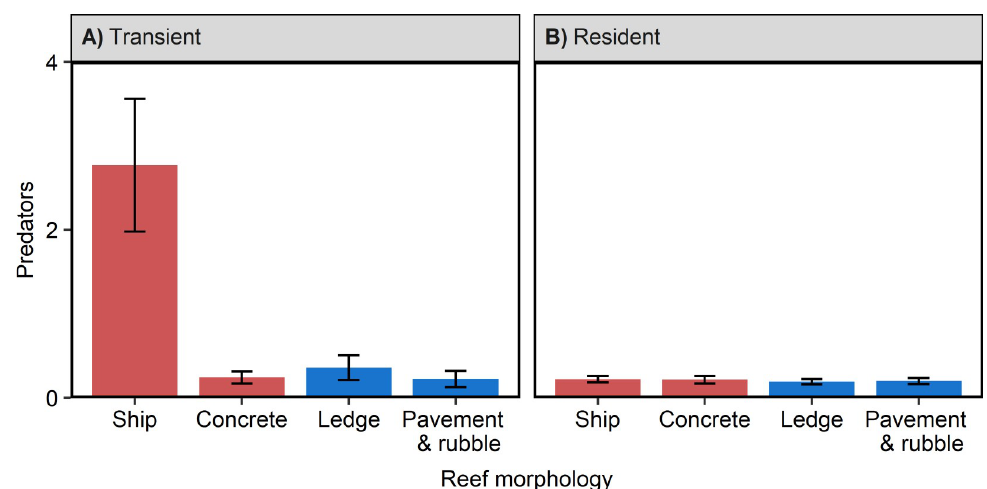
Fig 3. Mean observed predator density ( ± SE) per transect on artificial reefs (red) versus natural reefs (blue) by reef morphology for A) transient predators and B) resident predators. These values represent combined species-specific densities. N = 109 transects for artificial reefs and 127 transects for natural reefs.